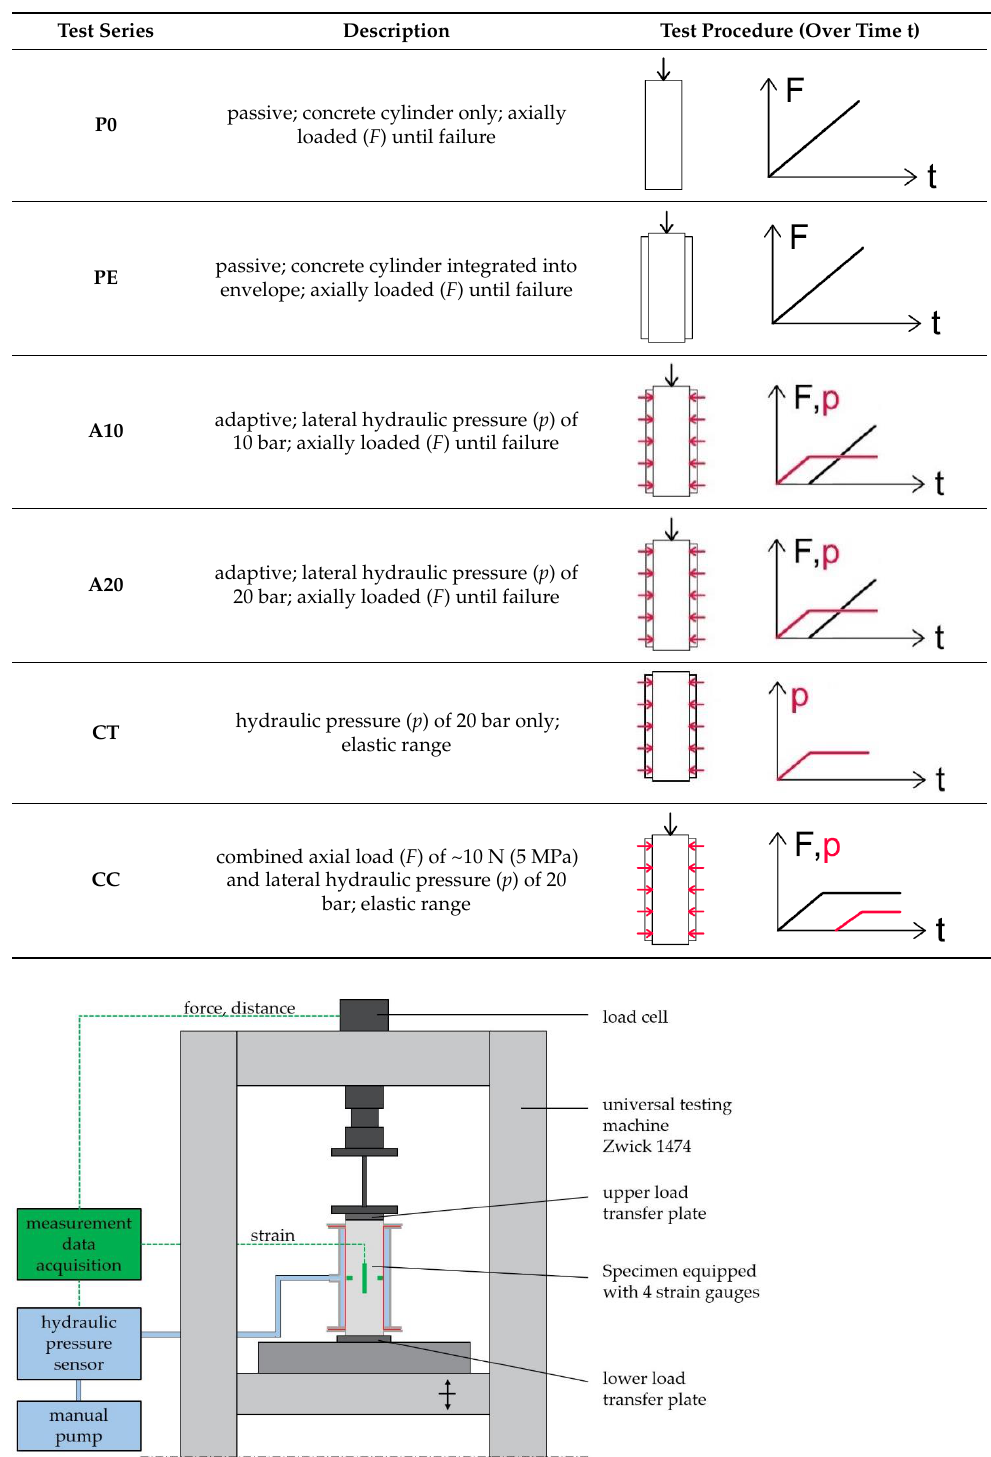
Figure 5. Schematic of the test setup for test series A10, A20 and CC. Table 2. Overview of the testing program.